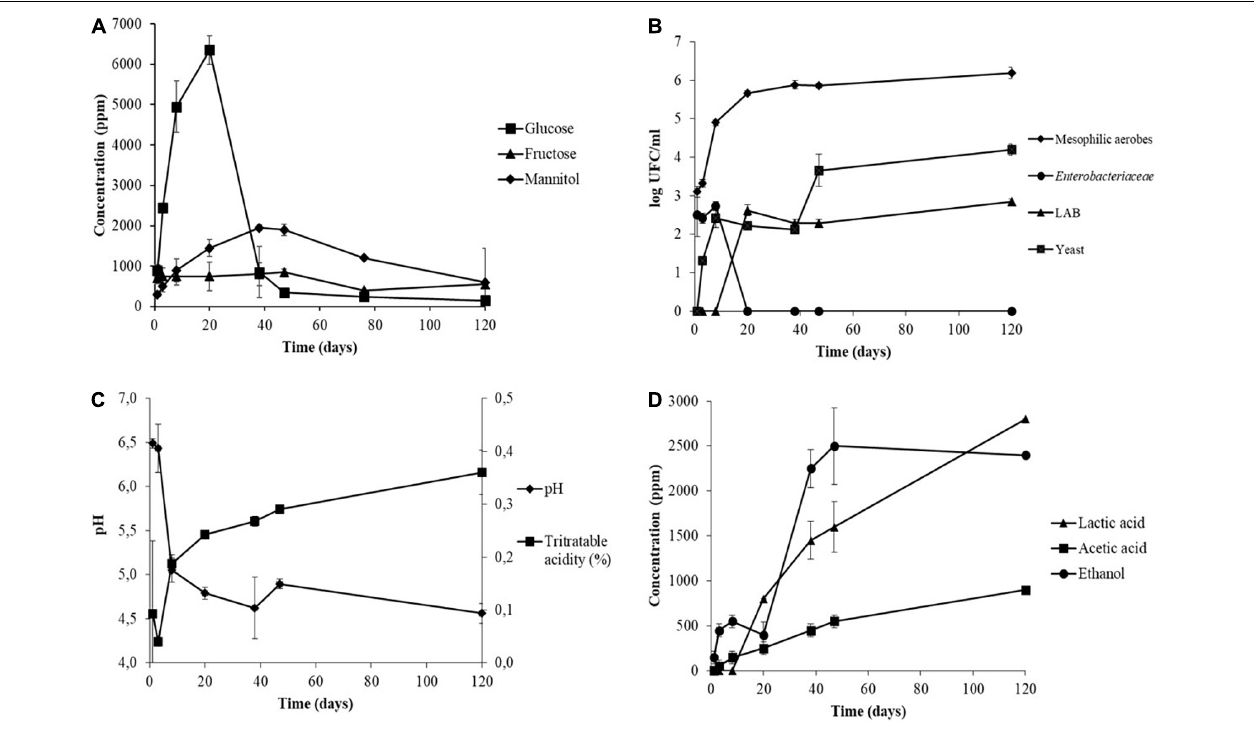
FIGURE 1 | Monitoring of pH and titratable acidity (A) , organic acids (B) , sugars (C) , and viable microbial population (D) during the industrial processing of Sigoise cultivar elaborated as Spanish-style green olives (sample Sig. 4). Standard deviation of duplicates is depicted on the error bars.